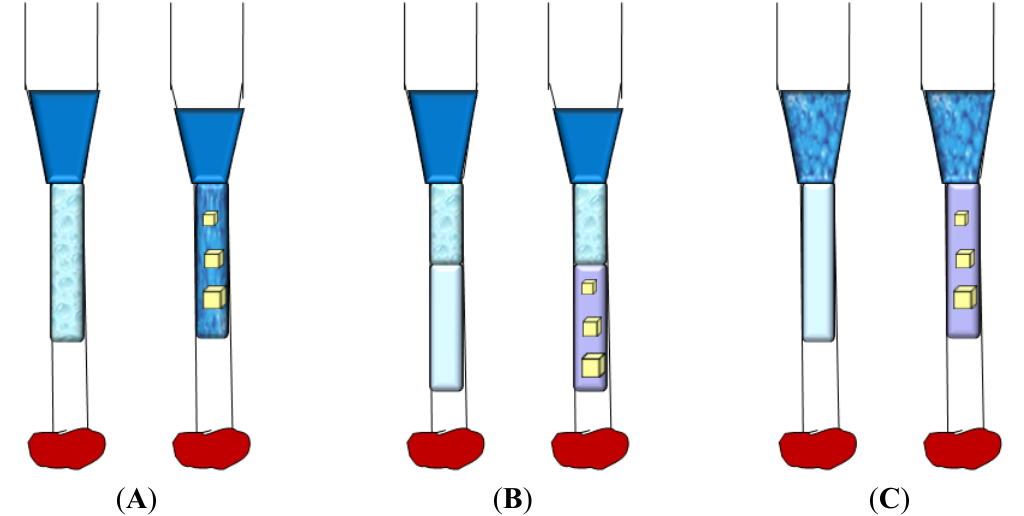
Figure 9. Counter diffusion techniques. In all the cases diffusion of the precipitant agent into the protein solution occurs through a gel. ( A ) The protein solution is gelified and the precipitant solution is overlayered on it; ( B ) Protein and precipitant solutions are separated by a small volume of gelled matrix; ( C ) The precipitant solution is loaded in a gelled matrix that is in contact with the protein